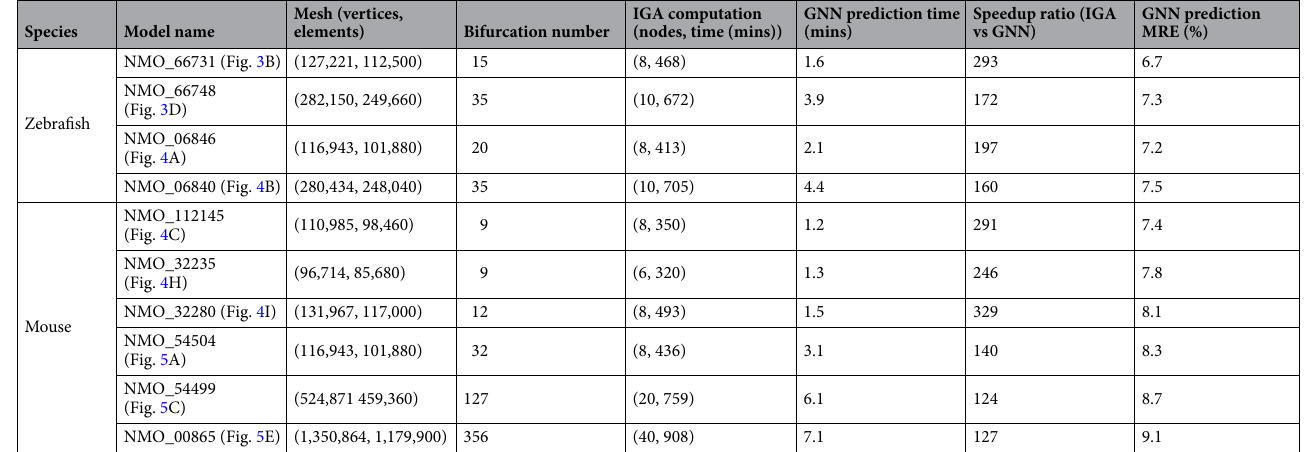
Table 2. Statistics of all tested complex neurite networks. Each node in Bridges has 28